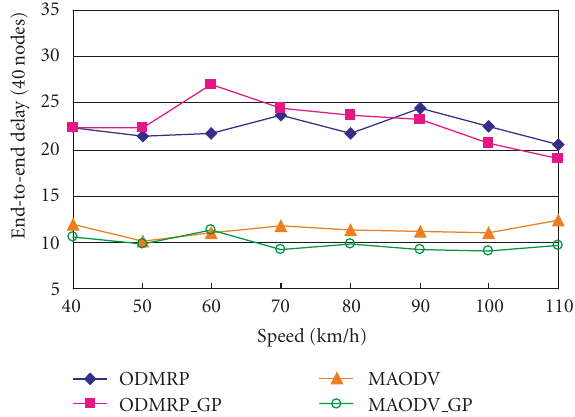
Figure 21: End-to-end delay versus mobility speed (40 nodes).